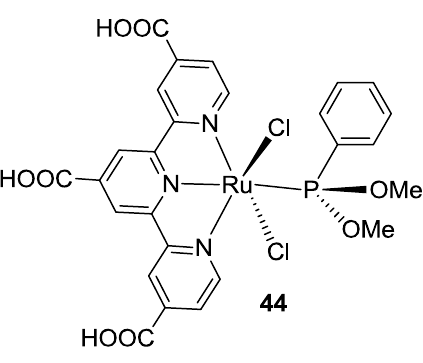
Figure 35. Phosphine-coordinated Ru(II) sensitizer by Kinoshita et al. [144].